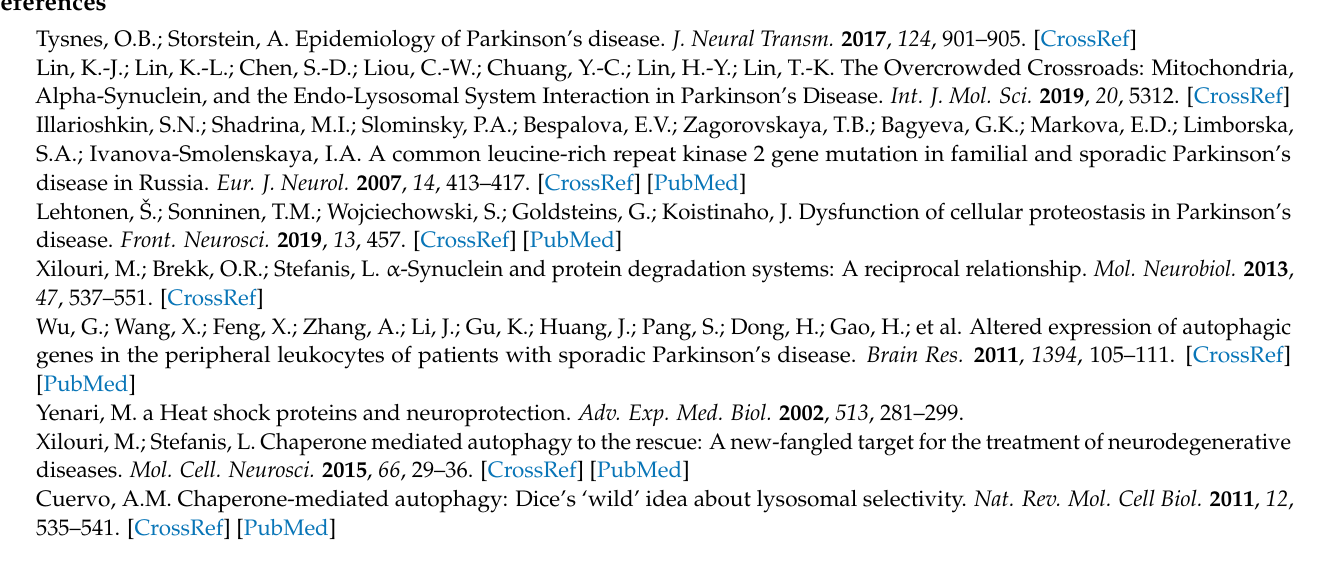
Figure S2: The design of primers for discrimination of the HSPA1A and HSPA1B expression; Figure S3: A correlation analysis between stress-induced HSPA gene expression in PBMC in PD patients and HDs; Figure S4: ROC curve analysis of HSPA1A/B gene expression levels as potential biomarkers of PD; Figure S5: ∆ HSP70 values calculated by subtraction of HSP70basal from HSP70heat levels in PMN in 14 PD patients and 14 HDs; Figure S6: Comparison of the stress-induced HSPA1A , HSPA1B and HSPA6 gene expression between two cell subsets: PBMC and PMN. Table S1: Oligonucleotide primers used in the